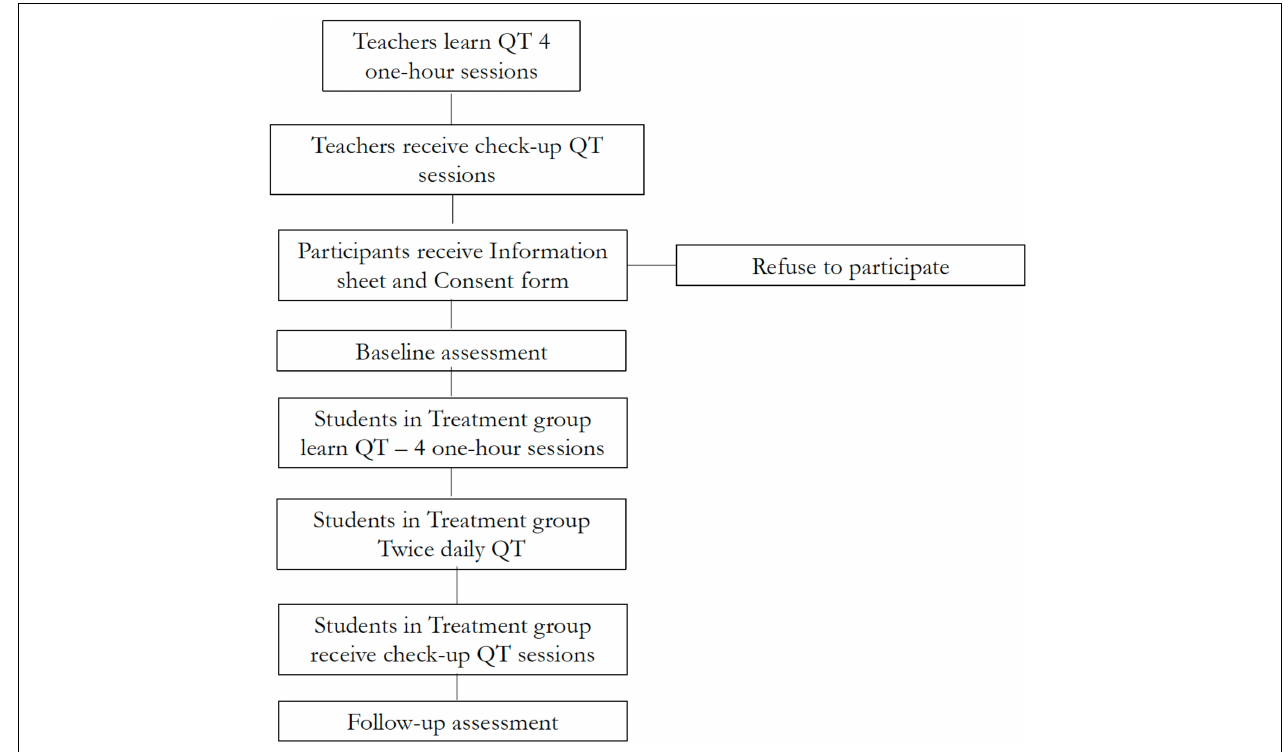
FIGURE 1 | Timeline of the study in both the United Kingdom and the Irish